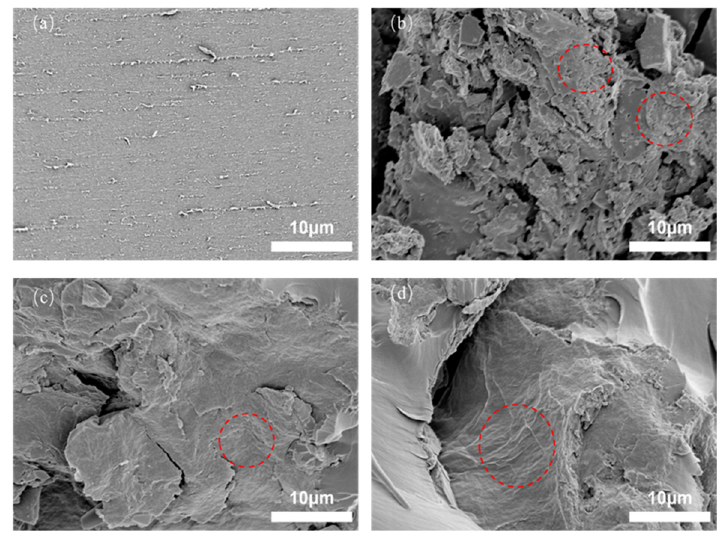
Figure 6. SEM images of the fracture surface for ( a ) pure EP, ( b ) rGO/EP, ( c ) PPD-Go /EP, ( d ) PPD- rGO/EP composites.